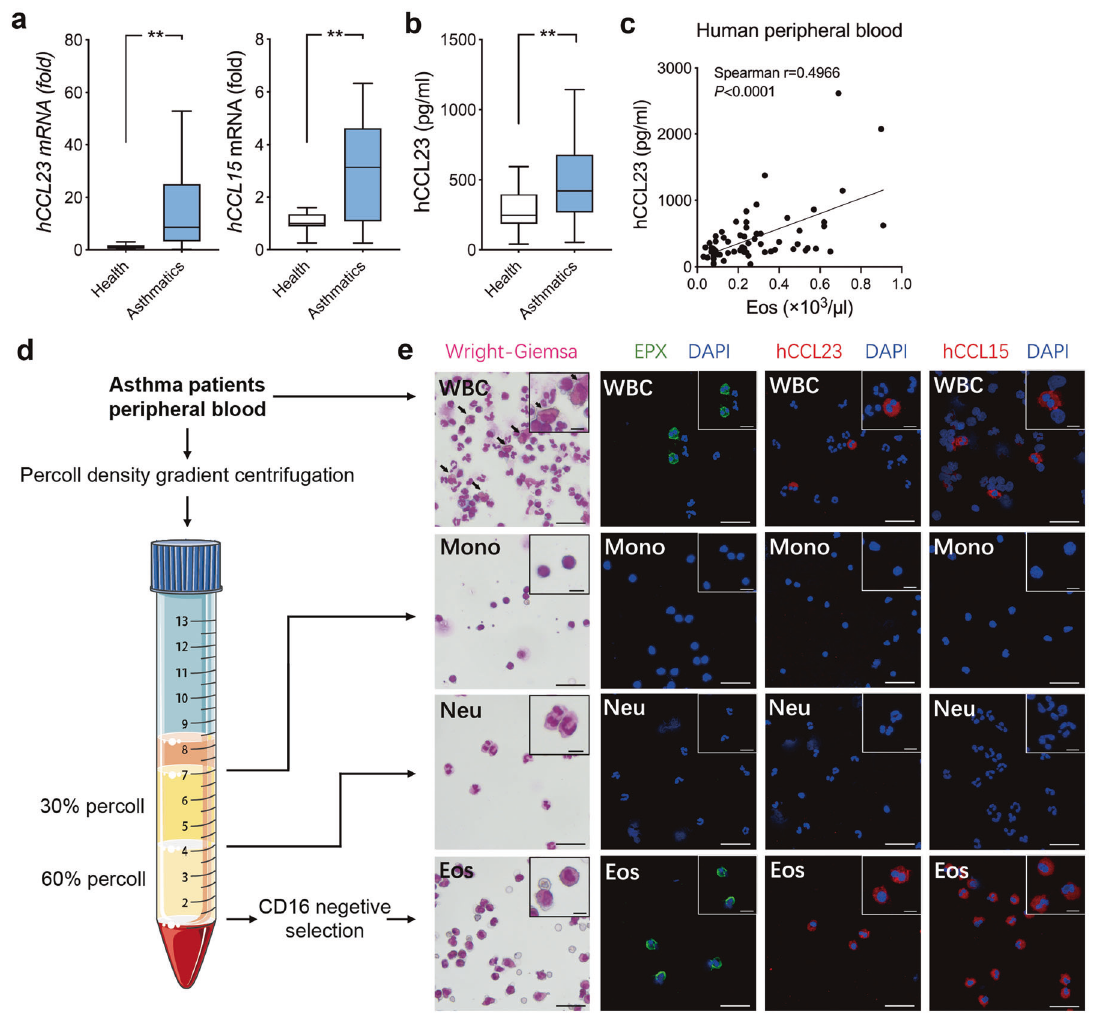
Fig. 1 Increased expressions of hCCL23 and hCCL15 in asthma patients. a Relative mRNA expressions of hCCL23 and hCCL15 in total white blood cells (WBCs) from asthma patients ( n = 16) versus healthy control subjects ( n = 16). b hCCL23 concentration measured by ELISA in the plasma of asthma patients ( n = 31) compared with healthy control ( n = 30). Data in a and b are presented as median (centerline), and the whiskers indicate no more than 1.5 times the interquartile range (the difference between 25th and 75th percentiles, shown in the box). c Correlation of hCCL23 protein levels with the number of eosinophils in human peripheral blood ( n = 61, linear regression and Spearman rank correlation). d Schematic illustration of peripheral blood WBCs isolating procedure from asthma patients. e Representative images of total WBCs and isolated subsets slides of Wright-Giemsa staining and immuno fl uorescence staining for EPX (green), hCCL23 (red), hCCL15 (red), and DAPI (blue). Scale bar, 40 μ m. Insets show high-power images in the upper right corner of each overlay. Scale bar, 10 μ m. ** P <0.01 by unpaired t